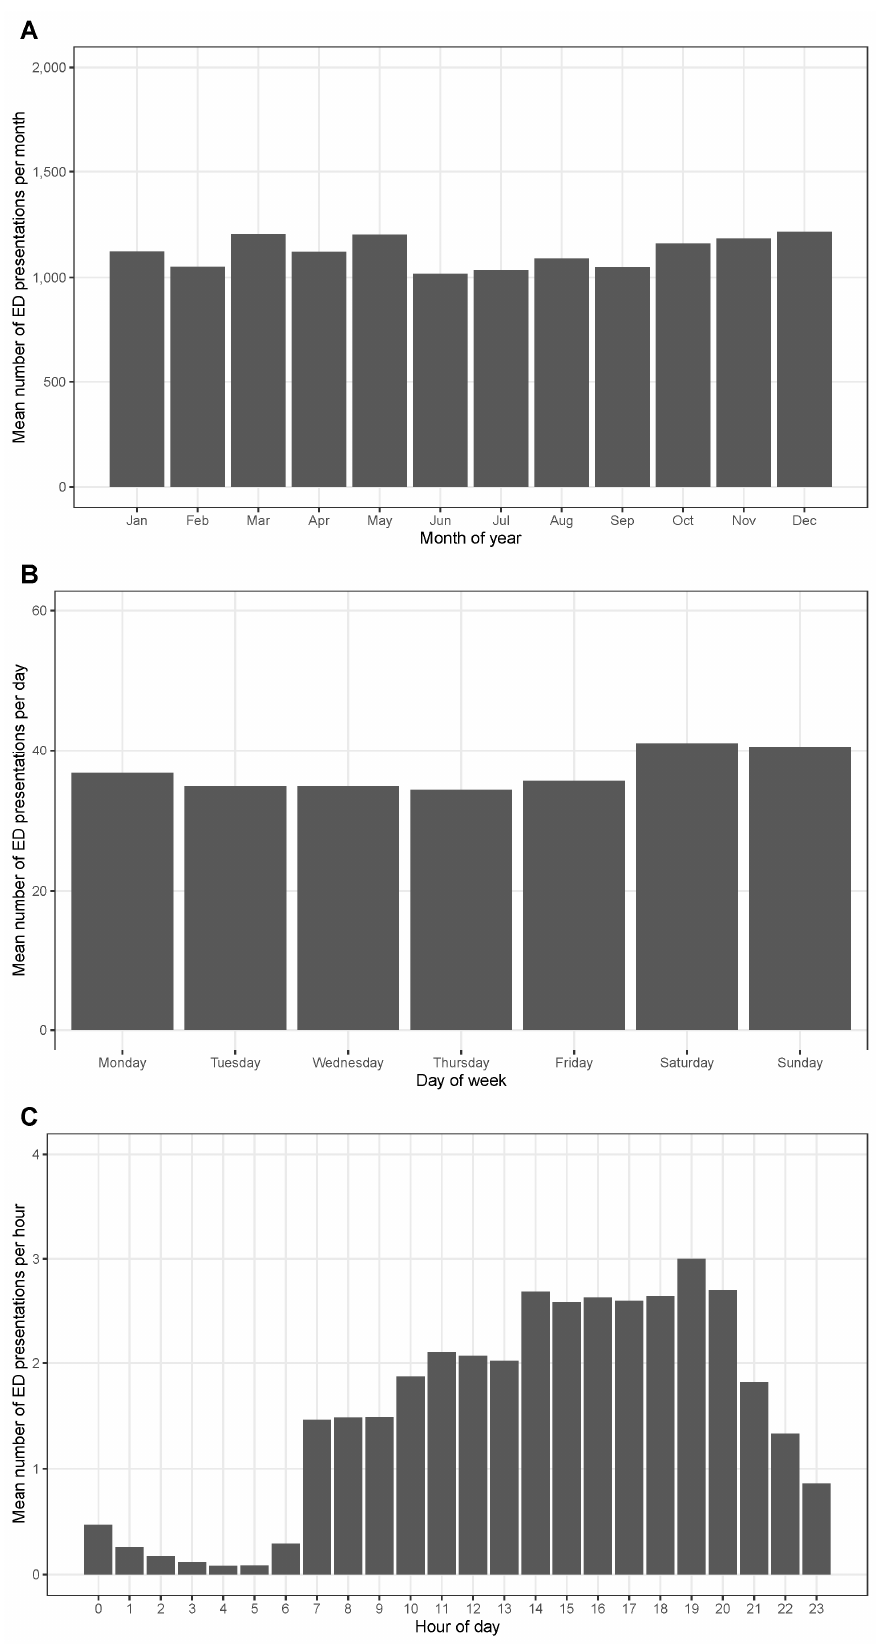
Figure 3. Mean number of paediatric injury-related ED presentations by month of year ( A ), day of week ( B ), and time of day ( C ).